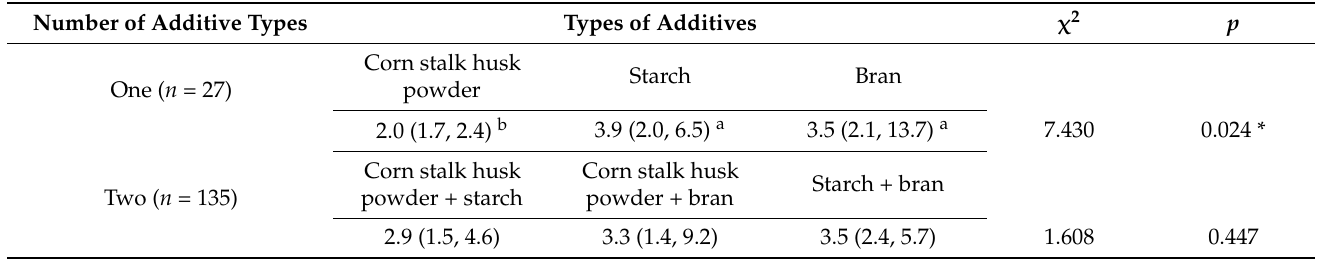
Table 3. Nonparametric test of the viable count at different additives (CFU/g;